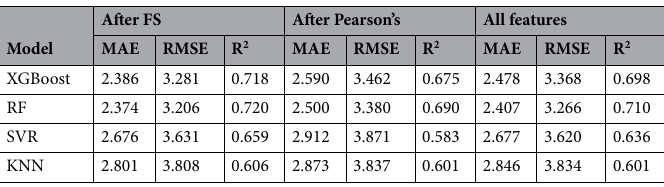
Table 3. MAE, RMSE and R 2 of each prediction model.